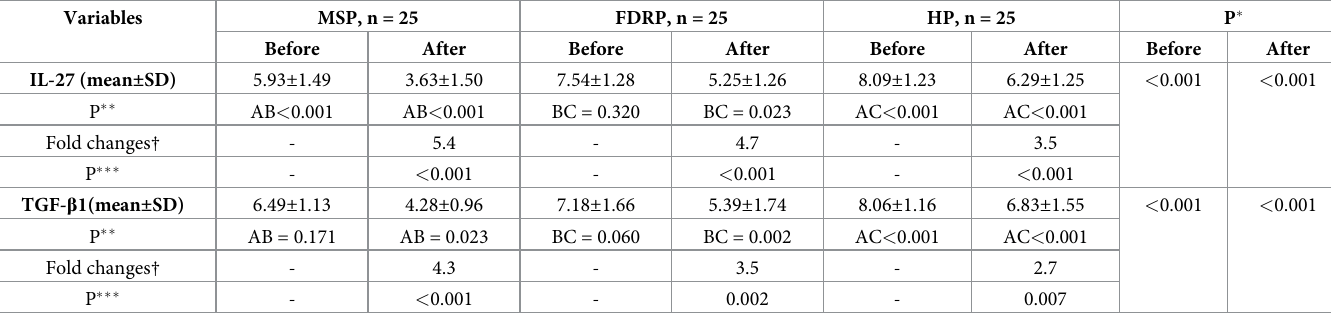
Table 2. Interleukin Δ CT in before and after eight weeks of treatment with vitamin D 3 .